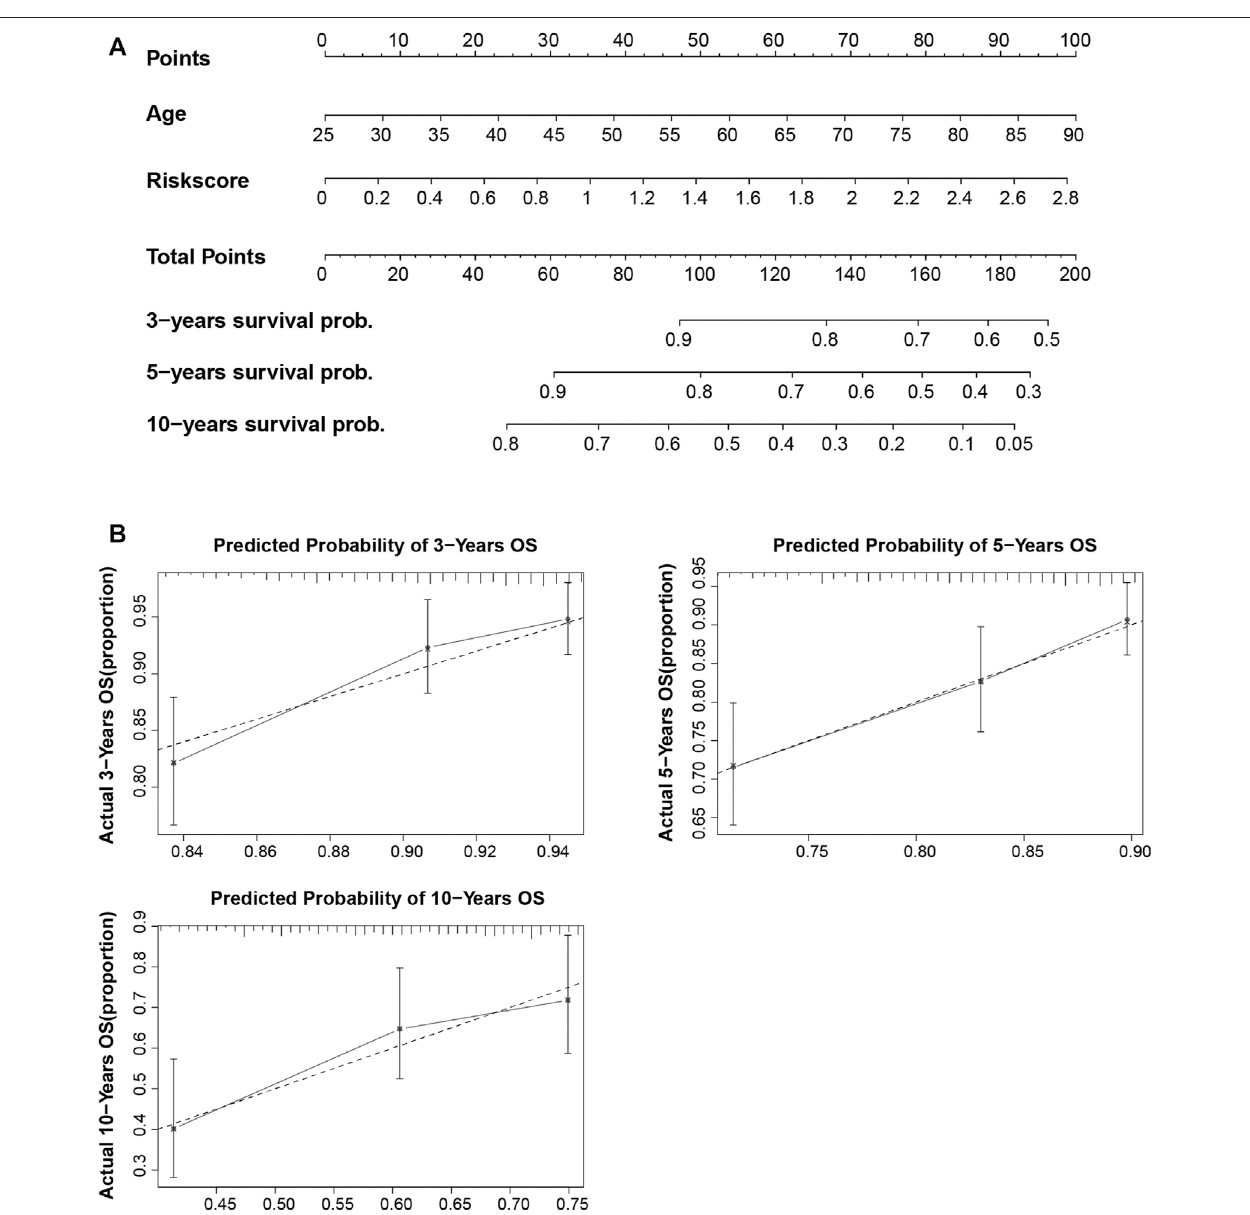
FIGURE 6 | Construction and calibration of the nomogram. (A) Construction of a nomogram based on age and risk score as independent prognostic factors. (B) The calibration curve revealed that the nomogram was well calibrated; the 3-, 5-, and 10-years overall survival showed an optimal agreement between the actual observation and nomogram